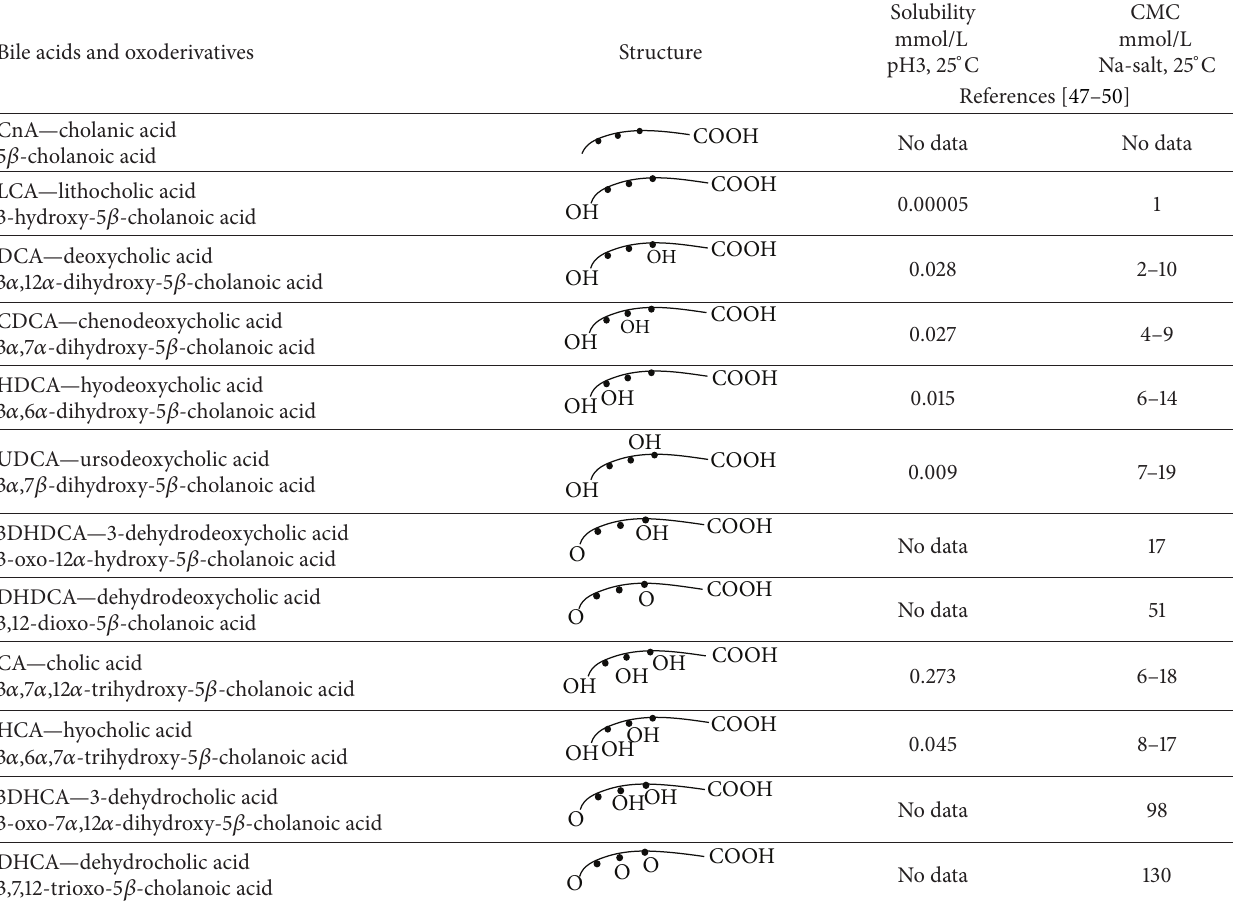
Bile acids and oxoderivatives Structure